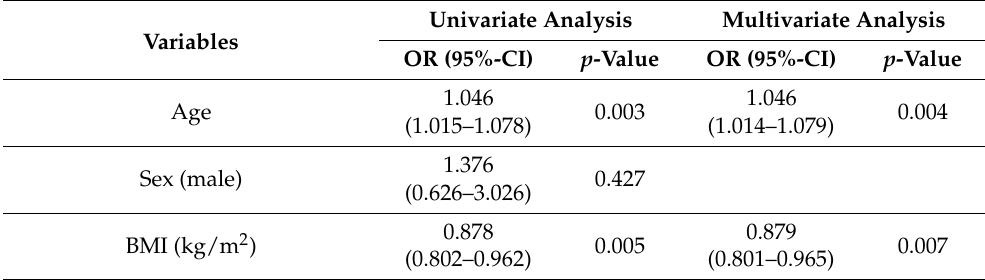
Table 2. Factors associated with the presence of sarcopenia in liver surgery